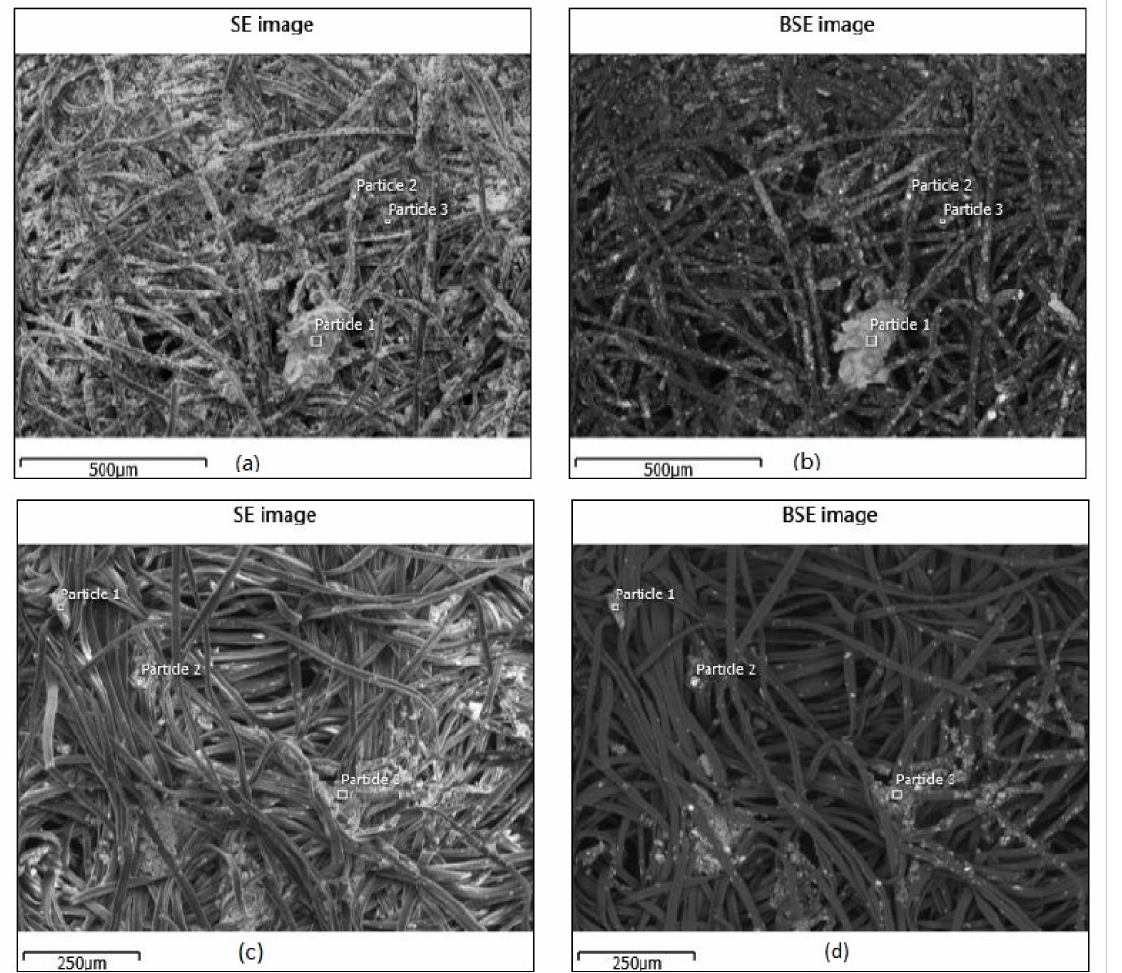
Figure 4. ( a ) SEM images showing morphology of Swab Sample from TS02, SE image, ( b ) SEM images showing morphology of Swab Sample from TS02, BSE image. ( c ) SEM images showing morphology of Swab from TS10, SE image. ( d ) SEM images showing morphology of Swab from TS10, BSE image.